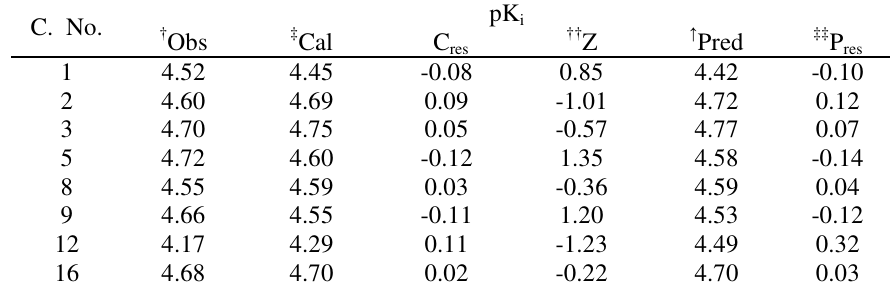
Table 4. PPAR- α agonist activity of 5-substituted-2-benzoylamino benzoic acid analogs using eqn.